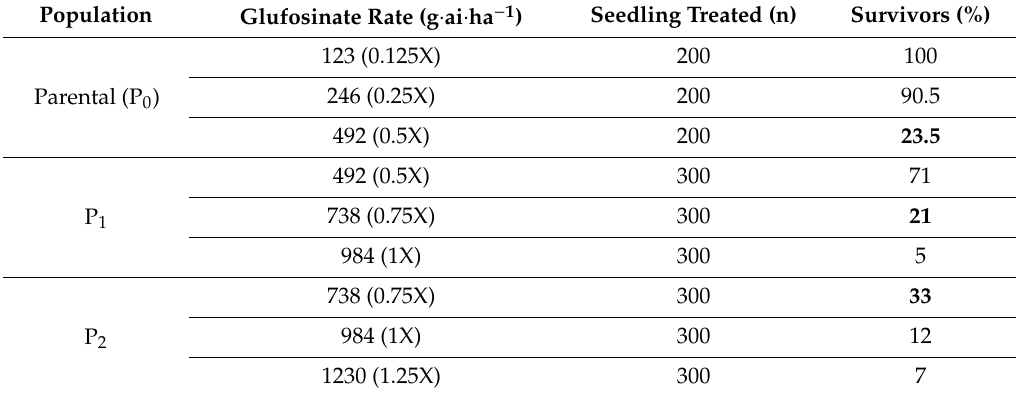
Note: Bold text and grey highlighted boxes indicate the rates from which surviving plants were selected for subsequent recurrent